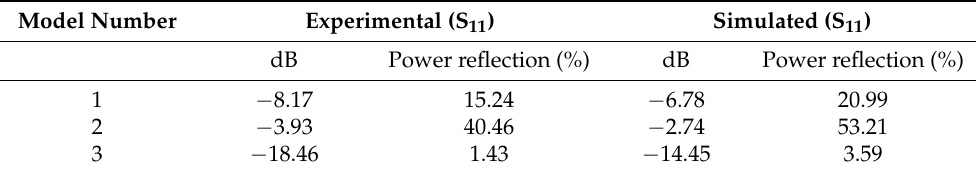
Table 2. Values of the scattering parameter S11 for the validation of the electromagnetic model. Model